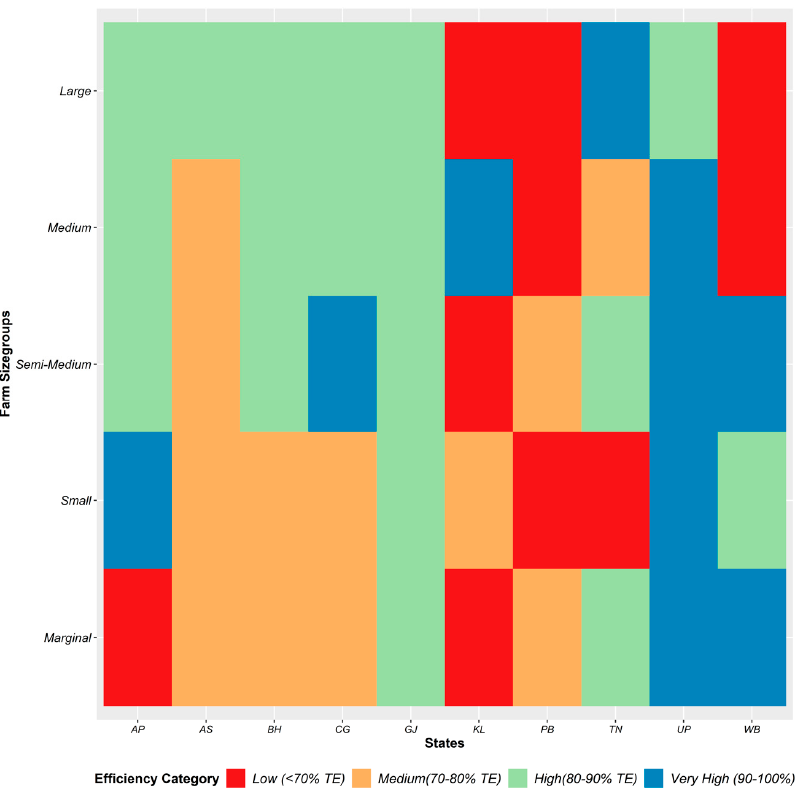
Figure 2. Heatmap showing the distribution of the technical efficiency across the states and farmer classes in paddy production in India in the AY 2016–2017. The distribution graph (Figure 3) suggests that in all of the states under study, the proportions of farmers operating at high and very high technical efficiency levels were high except for Gujarat and Kerala, where a significant chunk of farmers was operating at the lowest technical efficiency level. Skewed distribution can be seen in states like Uttar Pradesh, West Bengal, Bihar, Gujarat and Kerala, showing a high level of instability in input management practices.